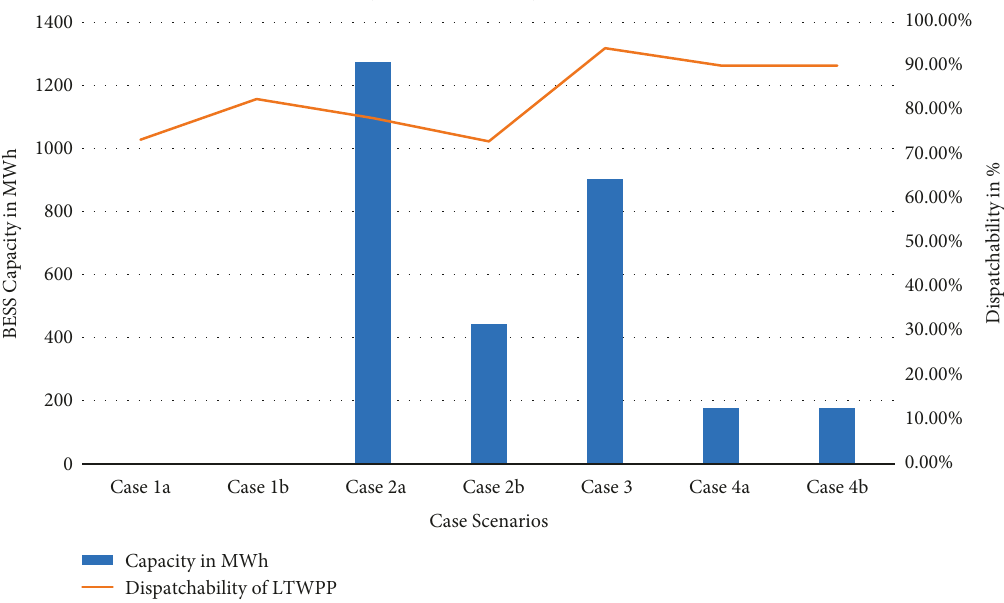
Figure 22: Comparison of BESS capacity and dispatchability of